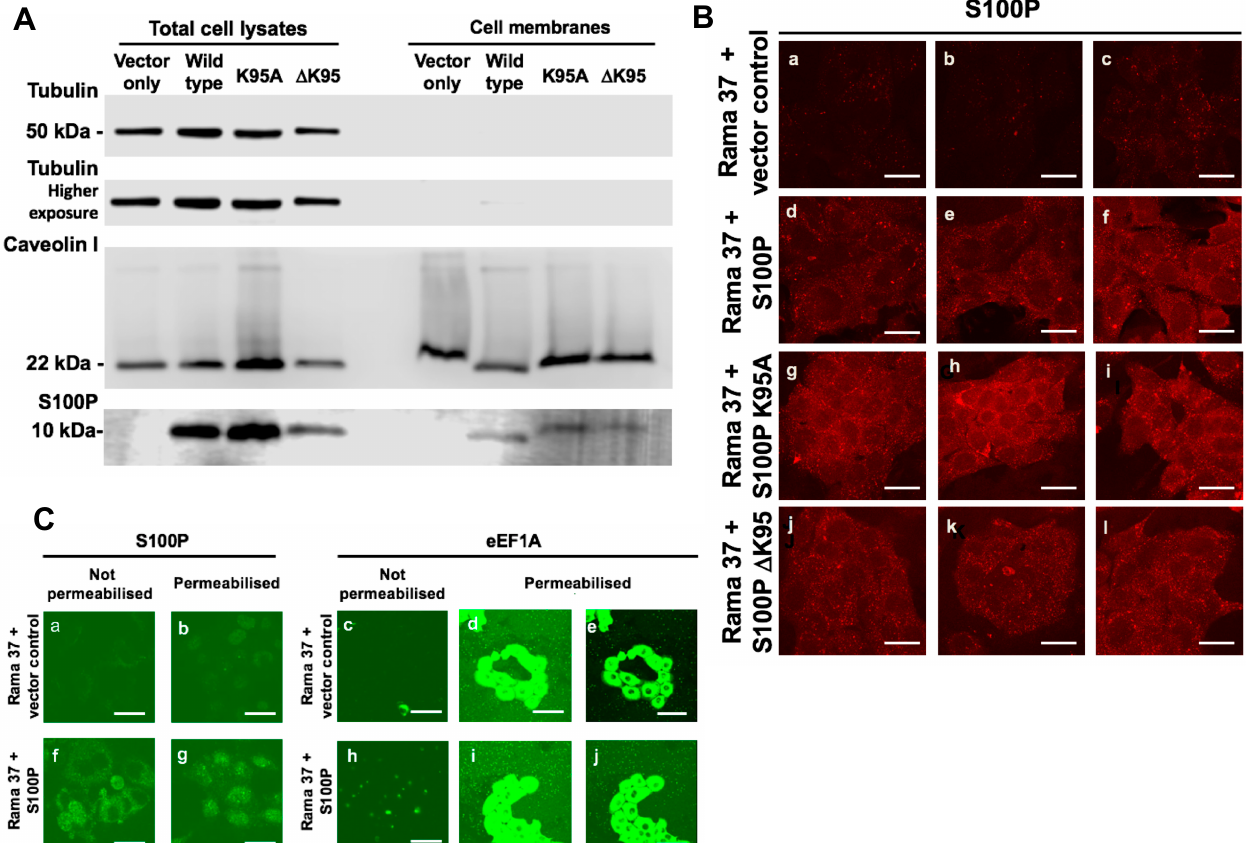
Figure 3. Association of S100P with cell membranes. ( A ) Total cell extracts and membrane fractions prepared as described in Materials and Methods from Rama 37 cells expressing S100P proteins and were subjected to Western blotting to detect S100P protein, the cytoplasmic marker, tubulin, and the plasma membrane marker, caveolin 1. ( B ) Living cells not expressing S100P (Rama 37 + vector control; panels a – c ) or expressing wild-type S100P (Rama 37 + S100P; panels d – f ), K95A mutant S100P (Rama 37 + S100P K95A; panels g – i ), or S100P protein with the C-terminal amino acid deleted (Rama 37 + S100P ∆ K95; panels j – l ) were incubated with S100P antibody in the culture medium, and bound antibodies were detected with Cy-3-labelled secondary antibody, as described in Materials and Methods and observed with a Zeiss LSM510 confocal laser scanning microscope. Three separate typical fields are shown for each cell line. ( C ) Antibodies directed at S100P (panels a , f ) or cytoplasmic protein, eEF1A (panels c , h ), were added to the culture medium of living S100P-negative Rama 37 cells (Rama 37 + vector control; panels a , c ) or S100P-positive Rama 37 cells (Rama 37 + S100P; panels f , h ). Parallel cultures of S100P-negative cells (Rama 37 + vector control; panels b , d , e ) and S100P-positive cells (Rama 37 + S100P; panels g , i , j ) were permeabilised before being treated with the antibodies directed at S100P (permeabilised; panels b , g ) or eEF1A (permeabilised; panels d , e , i , j ). Following fixation, bound antibodies were detected with fluorescein isothiocyanate-conjugated secondary antibodies (Materials and Methods) and observed with a Zeiss LSM510 confocal laser scanning microscope. Panels ( e , j ) show the same fields as panels ( d , i ), but the intensity of the fluorescence signal has been reduced to show individual cells. Bars, ( B , C ) = 50 μ m.